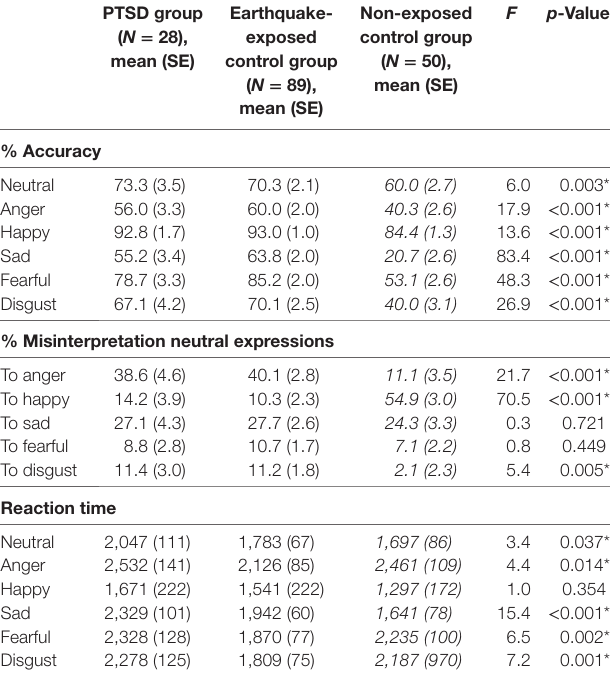
TaBle 2 | ANCOVA showing group effects of facial expression recognition in posttraumatic stress disorder (PTSD), earthquake-exposed controls, and the non-exposed controls (in